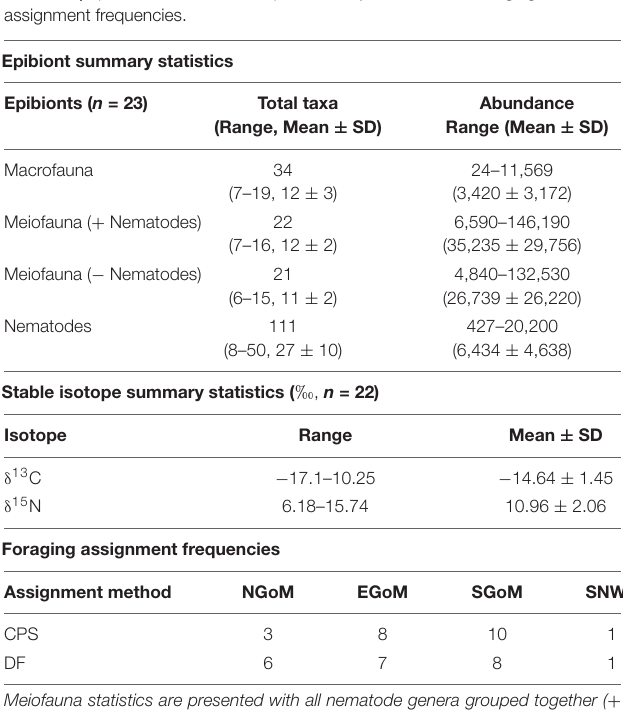
TABLE 1 | Epibiont and stable isotope summary statistics and foraging assignment